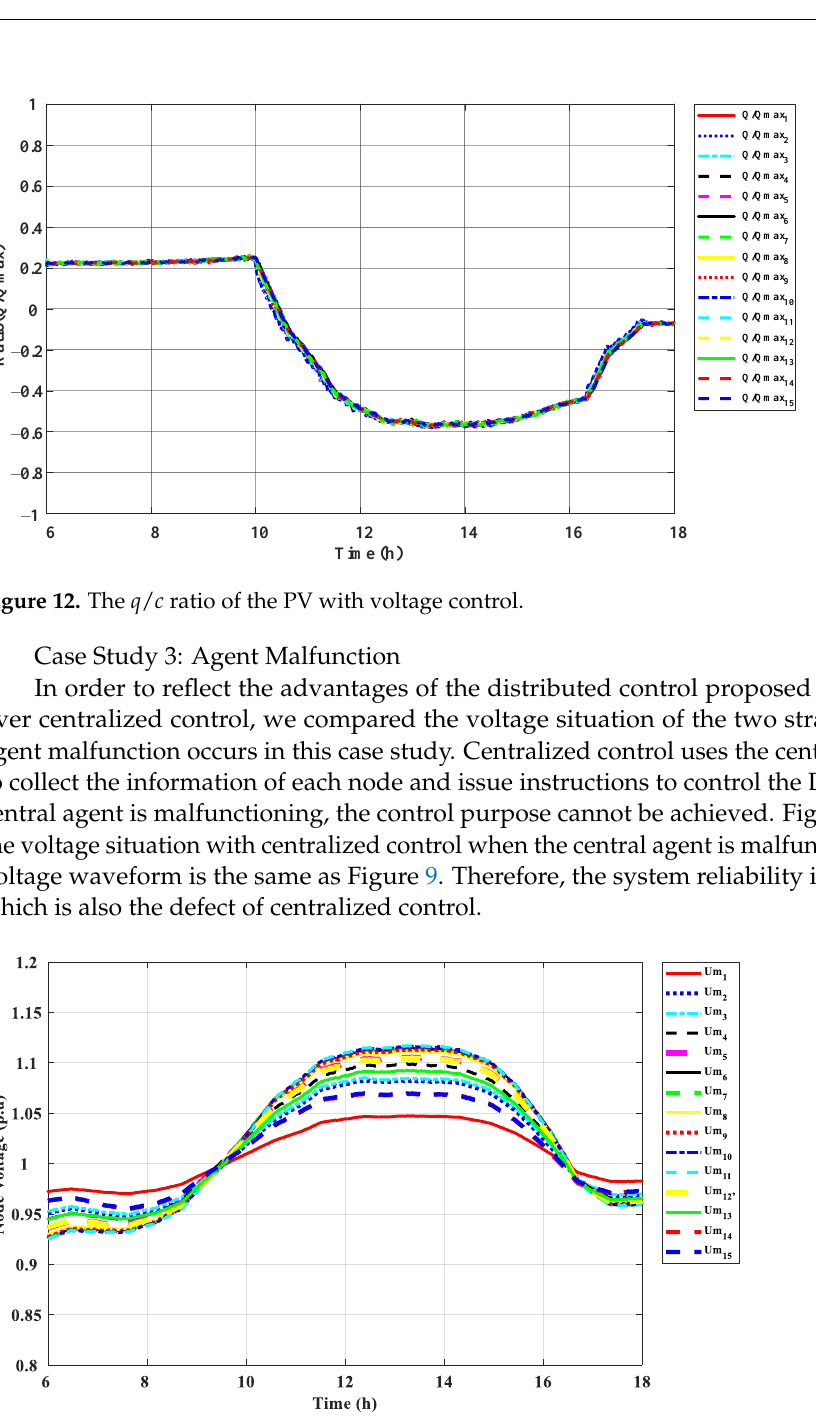
Figure 11. The reactive output of PV with voltage control.